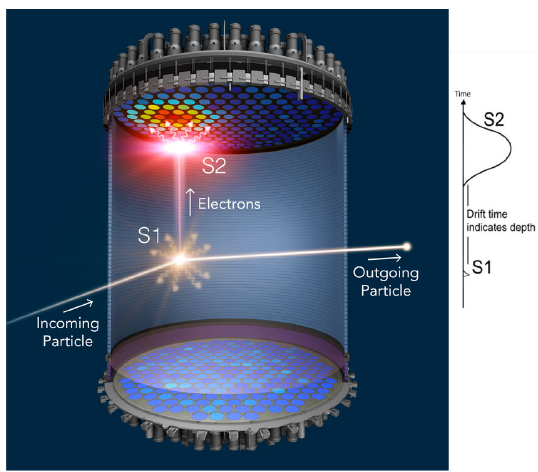
Figure 30: The operating principle of a liquid Xenon TPC using the XENON-1T de- tector as an example. Figure from Ref. [ 42 ] .